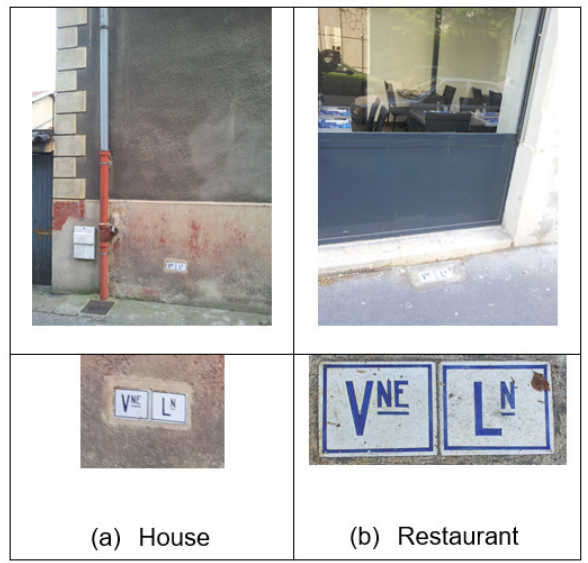
Figure 4. Example of urban objects split by administrative boundaries in which V NE and L N respectively